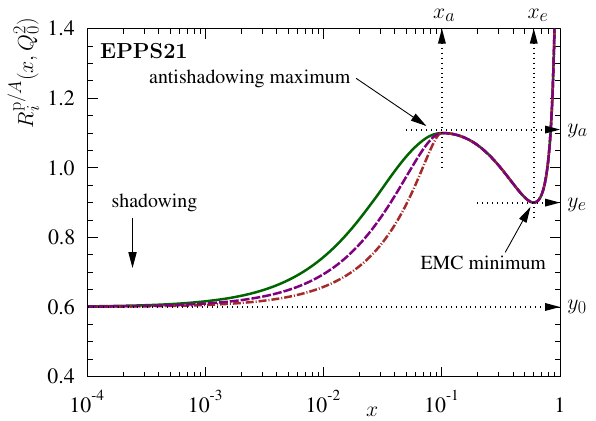
( x , Q 2 ) . The solid i 0